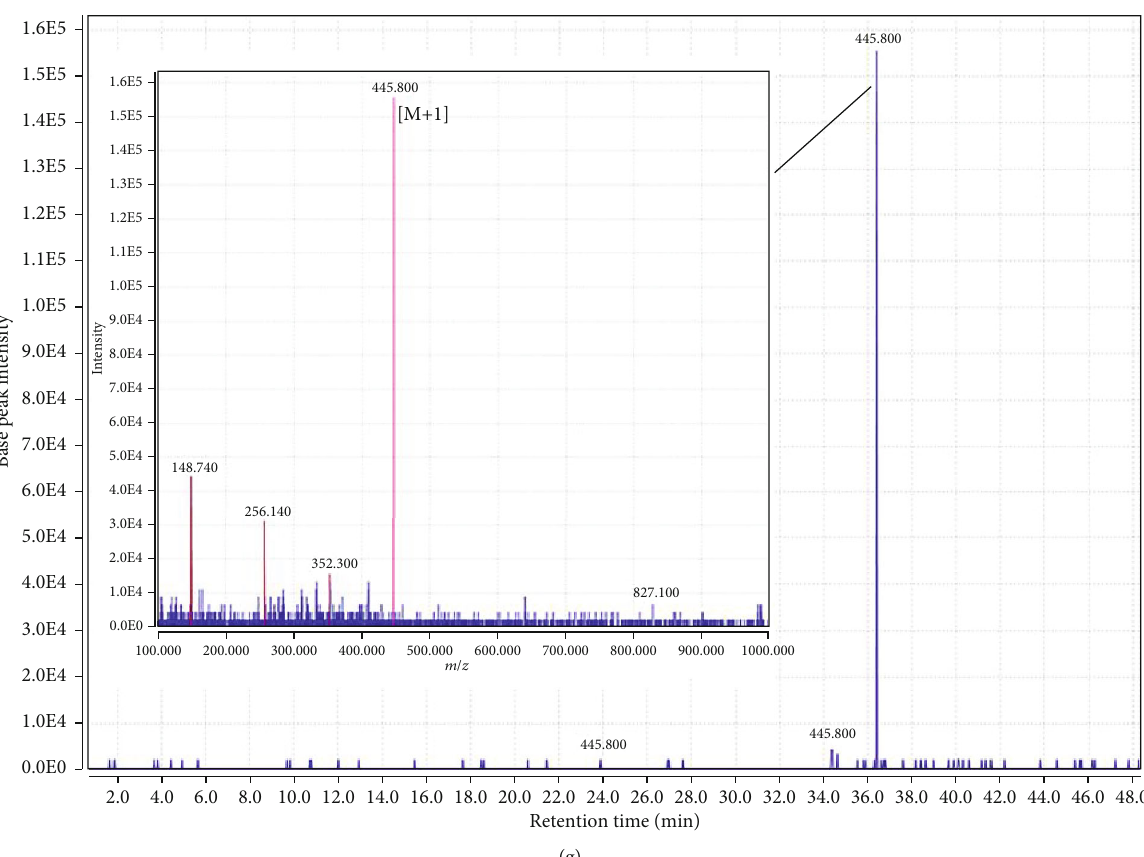
Figure 1: (a) The total ion chromatogram of Portulaca oleracea extract; (b) chromatogram of dopa and corresponding mass adduct, ½ M + 1 (cid:2) , at m / z 198.120; (c) chromatogram of oleraceins D and corresponding mass adduct, ½ M + 1 (cid:2) , at m / z 696.84; (d) chromatogram of portulacanone D and corresponding mass adduct, ½ M + 1 (cid:2) , at m / z 299.76; (e) chromatogram of friedelane and corresponding mass adduct, ½ M + 1 (cid:2) , at m / z 413.34; (f) chromatogram of ribo fl avin and corresponding mass adduct, ½ M + 1 (cid:2) , at m / z 376.62; (g) chromatogram of aurantiamide acetate and corresponding mass adduct, ½ M + 1 (cid:2) , at m / z 445.8.